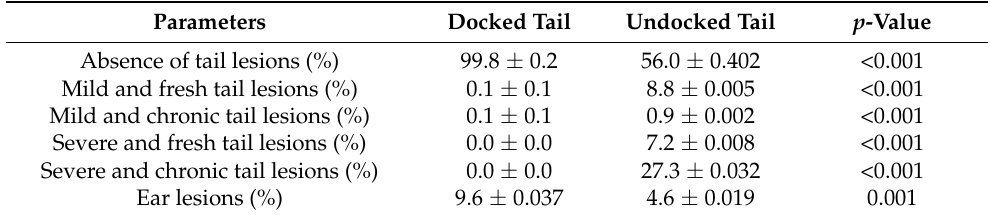
Table 2. Frequency of tail and ear lesions ( ± standard error) in relation to tail docking: data expressed as affected subjects/batch.